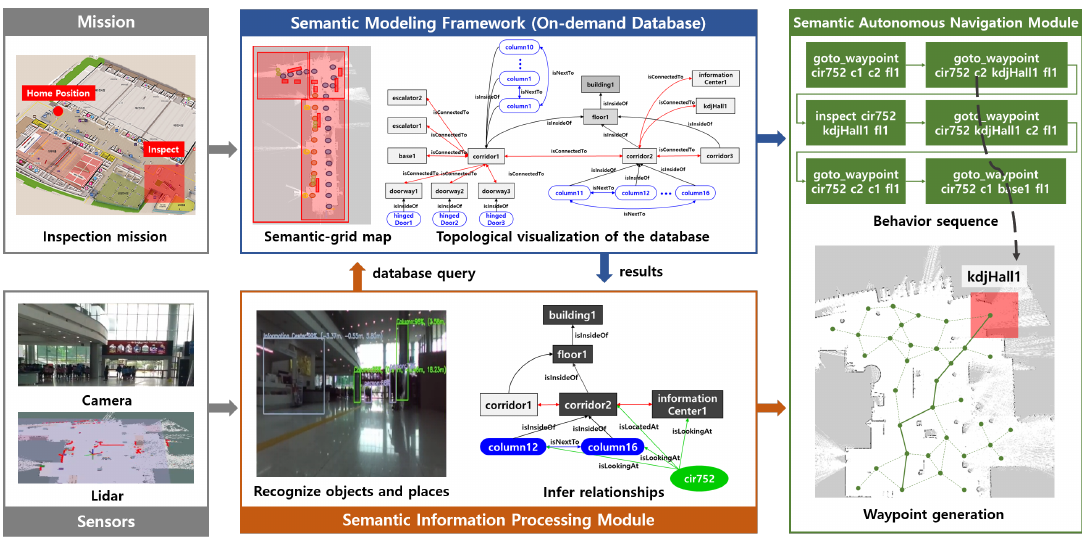
Figure 12. The TOSM-based autonomous navigation framework sequence